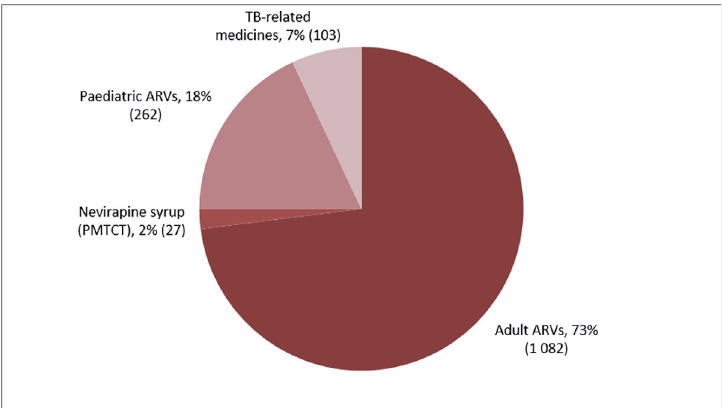
Fig 4. Breakdown by type of medicine of stock-outs of ARVs and TB-related medicines reported nationwide.